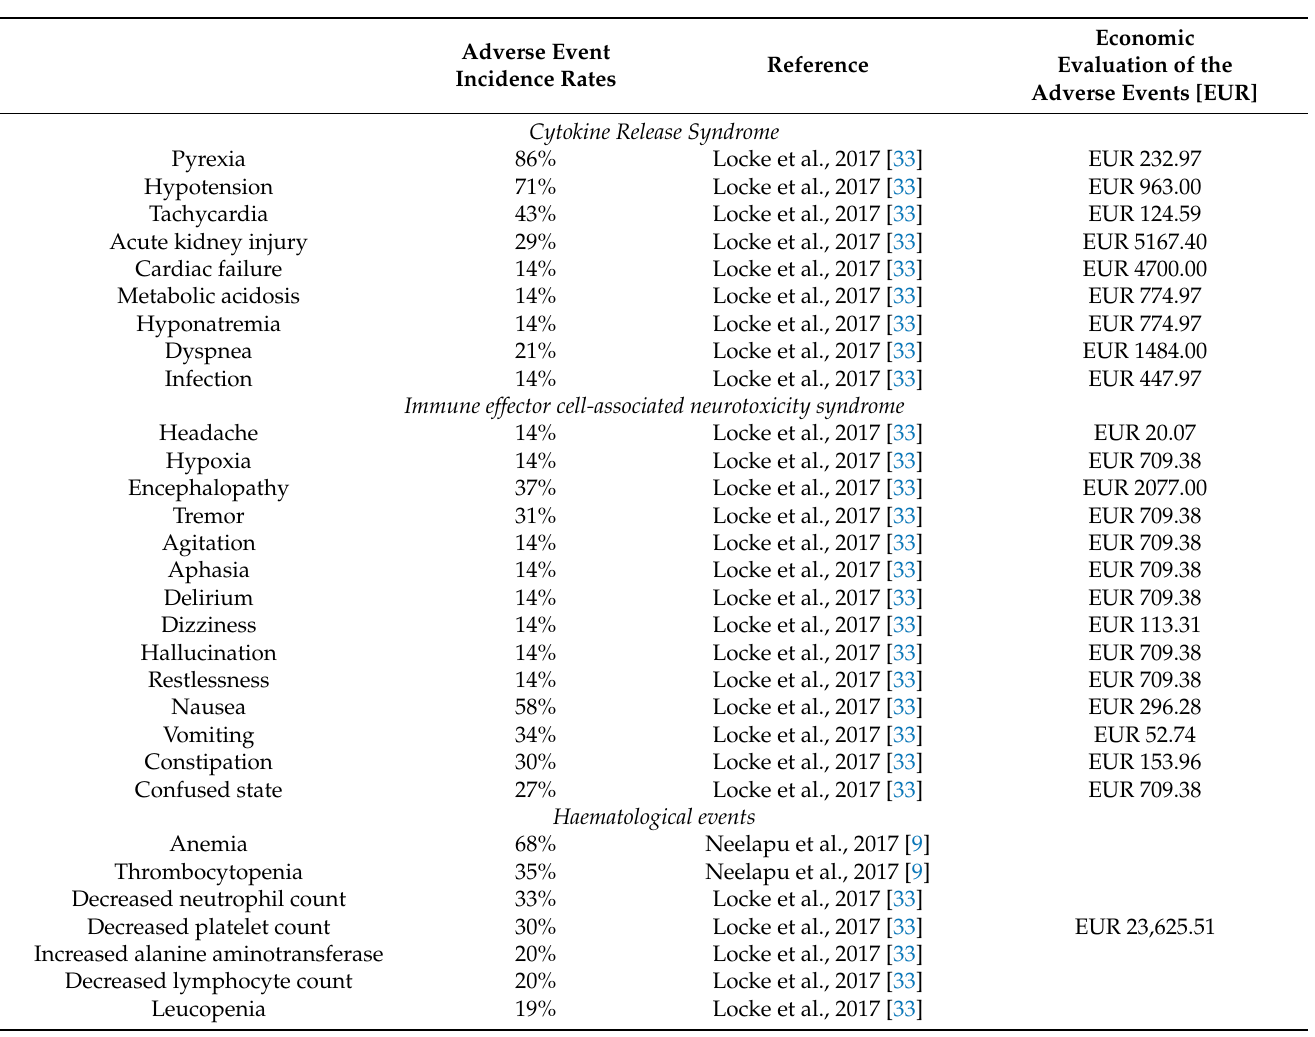
Table 2. CAR T-cell adverse event incidence rates reported in the literature and related economic evaluations.